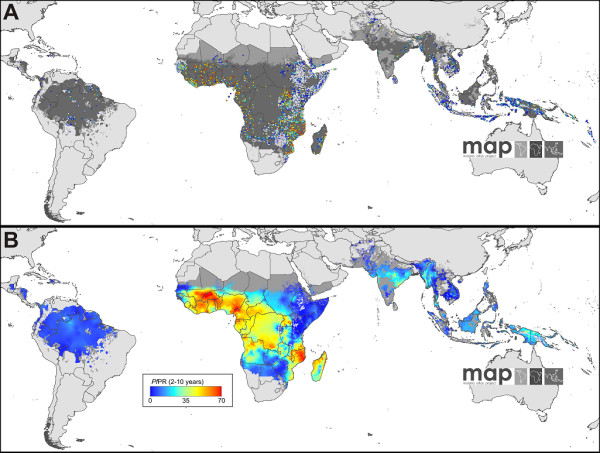
The spatial distribution of Plasmodium falciparum malaria endemicity in 2010. Panel A shows the 2010 spatial Limits of P. falciparum malaria risk defined by PfAPI with further medical intelligence, temperature and aridity Masks. Areas were defined as stable (dark grey areas, where PfAPI ≥0.1 per 1,000 pa), unstable (medium grey areas, where PfAPI < 0.1 per 1,000 pa) or no risk (light grey, where PfAPI = 0 per 1,000 pa). The community surveys of P. falciparum prevalence conducted between January 1985 and June 2010 are plotted. Of the 23,612 surveys collected, 22,212 satisfied the inclusion criteria for modelling (see Methods and Additional File 1, 2) and are shown here. The survey data are age-standardized [40] (PfPR2-10) and presented as a continuum of blue to red from 0%-100% (see map legend), with zero-valued surveys shown in white. Panel B shows the MBG point estimates of the annual mean PfPR2-10 for 2010 within the spatial limits of stable P. falciparum malaria transmission, displayed on the same colour scale. Areas of no risk or unstable risk are as in (A).